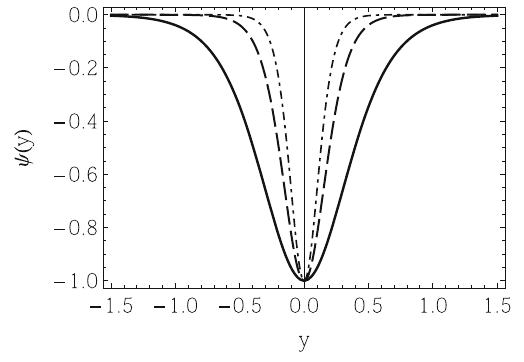
Fig. 3 Field ψ( y ) given by Eq. (28) for ψ 0 = − 1, a = 1 (solid line), a = 2 (dashed line) and a = 3 (dot-dashed